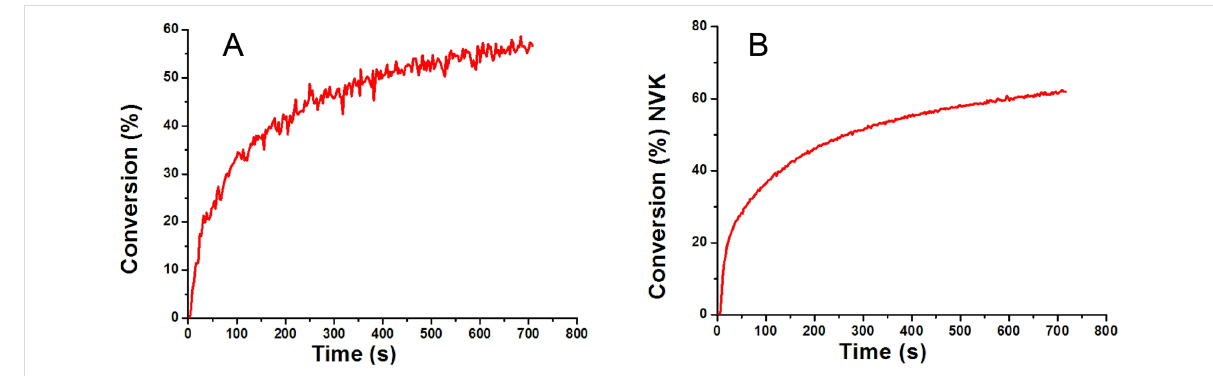
Figure 10: (A) Photopolymerization profile of EPOX; photoinitiating system: Ir(piq) 2 (tmd)/Ph 2 I + /NVK (1%/2%/3%); laser diode at 532 nm exposure (~100 mW/cm²); under air. (B) Conversion profile for the NVK double bond in the course of the polymerization.